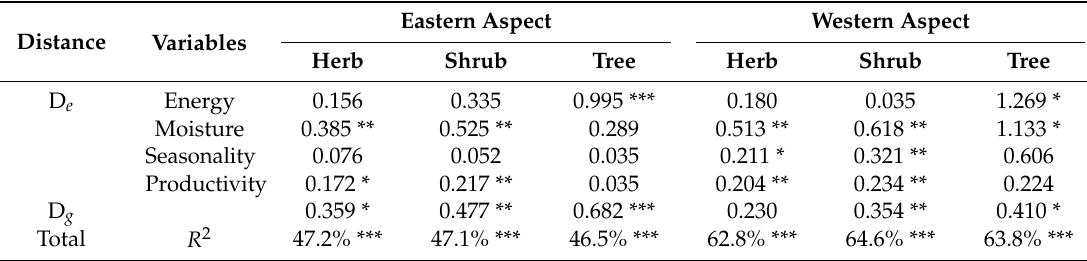
Table 4. Regression coefficients and regression R-squared values: multiple regression on distance matrices of beta diversity on the eastern and the western aspects of Baima Snow Mountain. D e and D g : Euclidian distance between two transects calculated for environmental variables or geographic coordinates (including elevation),